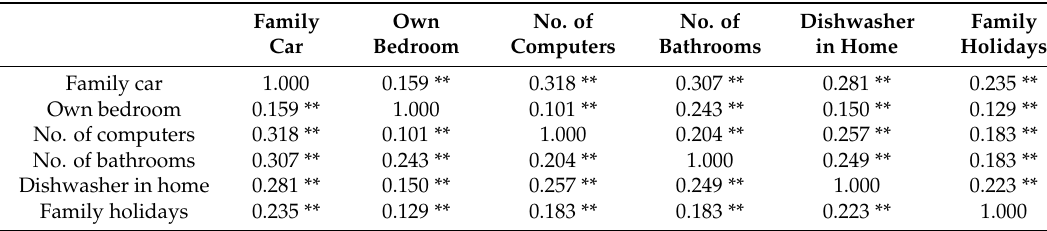
Table 6. Intercorrelations between item questions (Spearman’s